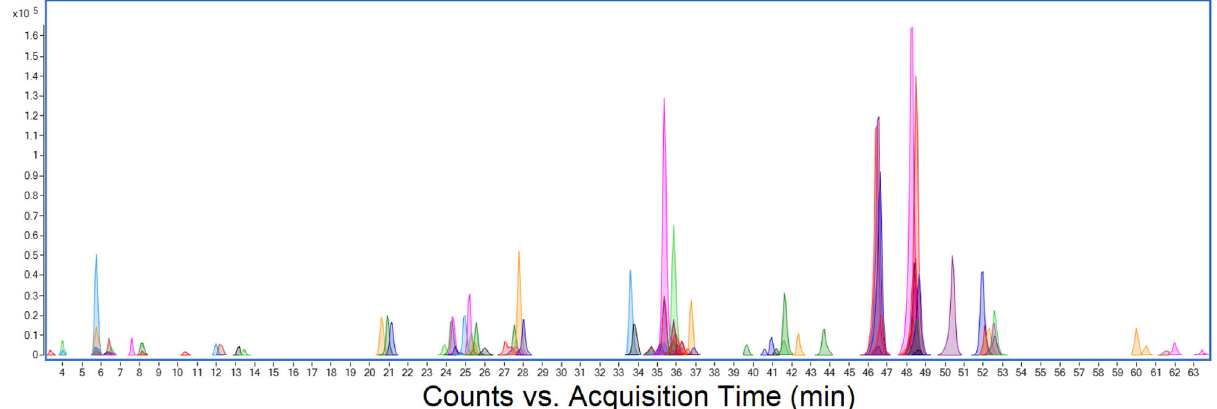
Fig. 2 Combined extracted ion chromatogram (EIC) for 140 observed Spike protein glycopeptides. Combined extracted ion chromatogram (EIC) for 140 observed Spike protein glycopeptides separated by 60-min reverse-phase LC – MS run showing peak resolution for peptides of different sequence, and also different glycoforms of the same peptide, which are unresolved and coelute within a 4-min retention time window. Peak volume (area) can be used to estimate the relative abundance of each glycopeptide